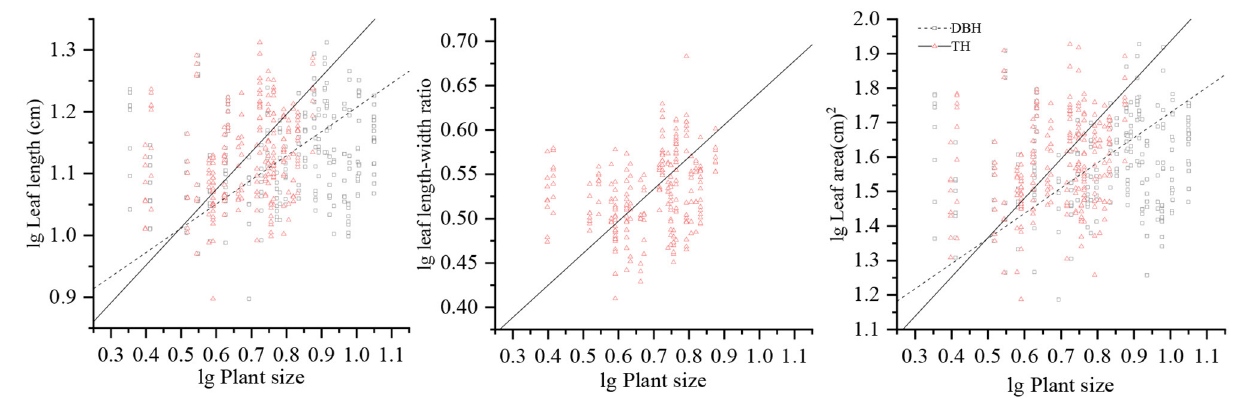
FIGURE 2 | Allometric relationships of LL, LL/LW, and LA with respect to DBH and TH. LL, leaf length; LW, leaf width; LL/LW, leaf length–leaf width ratio; LA, leaf area; DBH, diameter at breast height; TH, tree